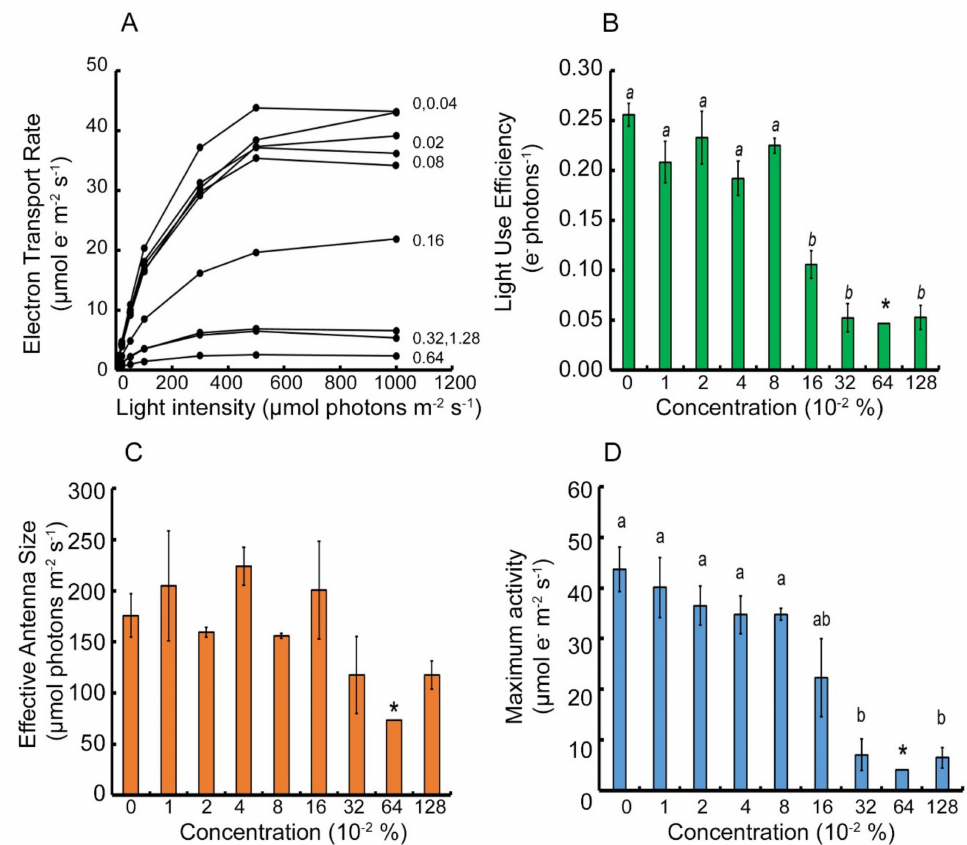
Figure 2. Parameterization of light response curves of Apple ( Malus domestica ) cultivar “Top Red” that experienced a Brevis ® inhibitor gradient for 2 days under laboratory conditions. Panel ( A ) represents light response curves data. Panels ( B – D ) represent the parametrization variables-Light Use Efficiency (LUE) (green), Effective antenna size (orange), and maximum Electron Transport Rate (ETR) (blue), respectively. The asterisk in the panels represent two biological repeats only, therefore no error bars are present. Each column is an average of three biological repeats. Error bars represent standard error of the mean. Inhibitor is given in percentage. Letter notations describe statistically significant difference at p <